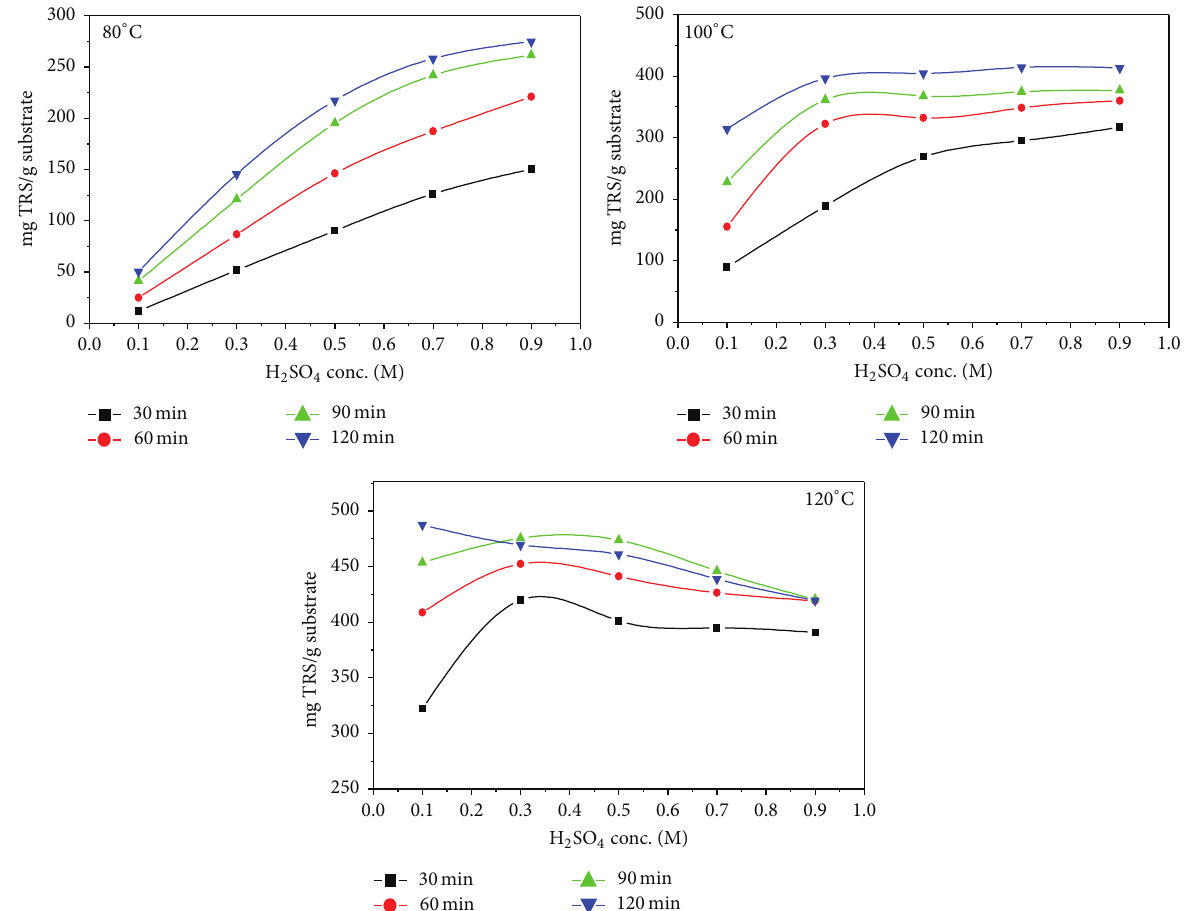
Figure 2: Effect of reaction time and H 2 SO 4 concentration at different temperature on the production of TRS from spent citronella biomass.